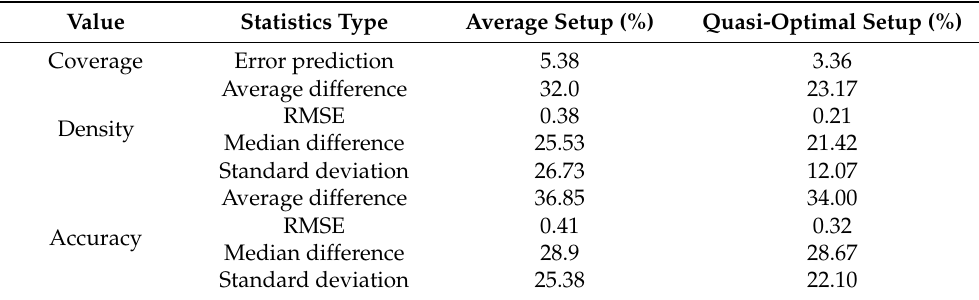
Table 6. Statistics for the difference between prediction and evaluation for different setups with outliers removed.